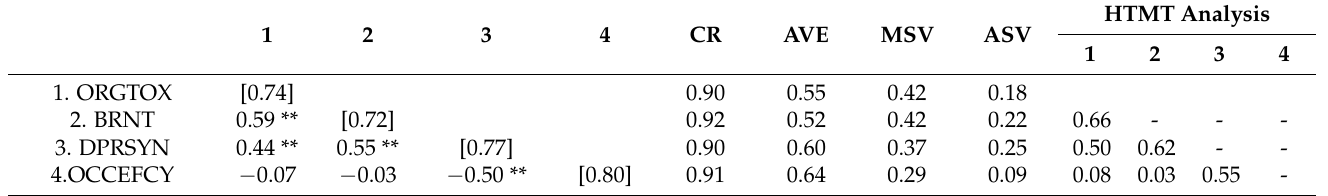
Table 3. Correlations, convergent and discriminant validity of observed variables.